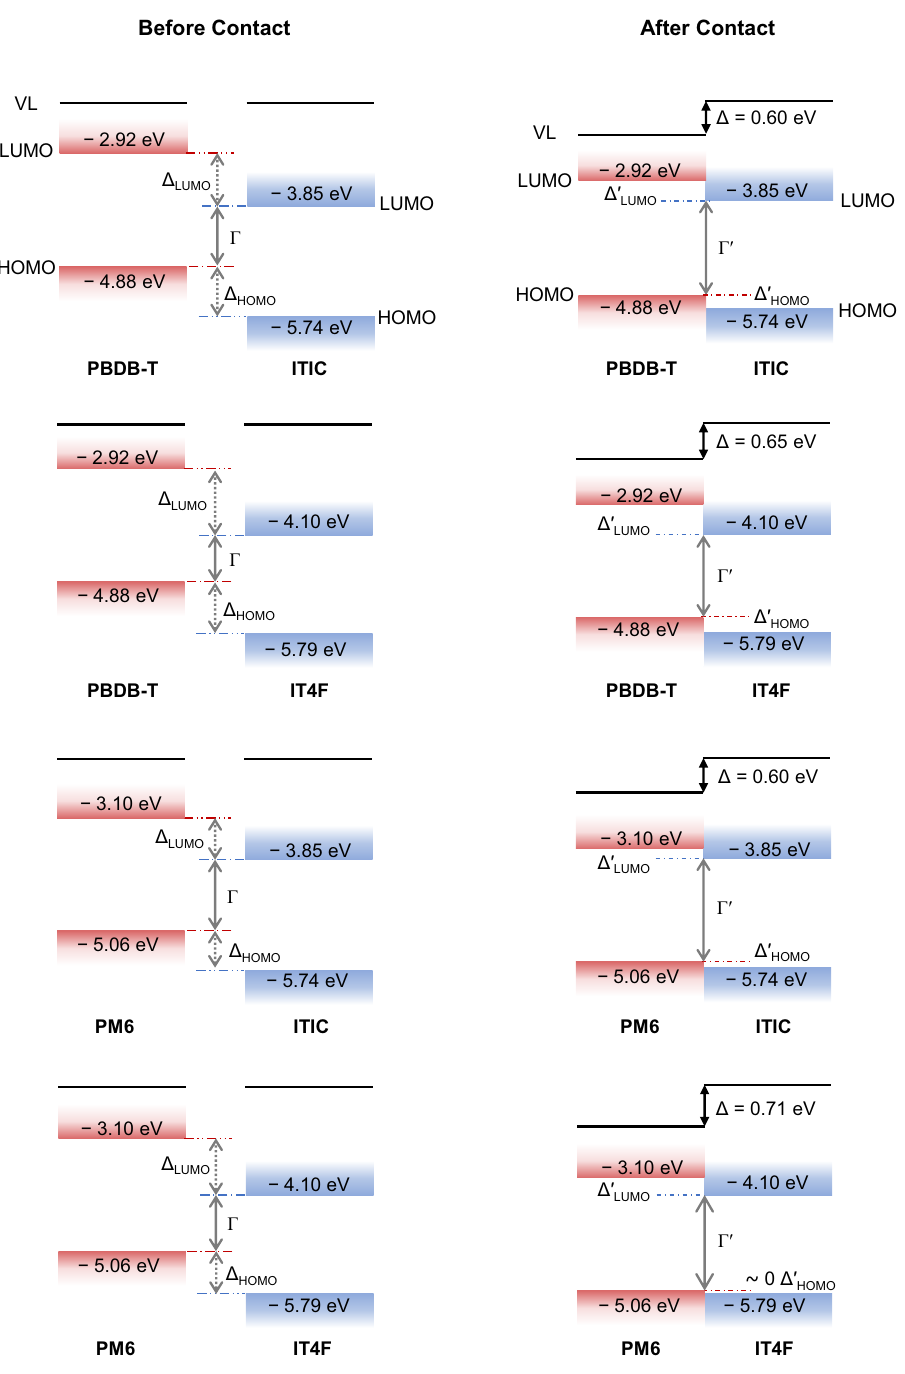
Fig. 3 Energy level diagrams of D – A interfaces before and after contact. All HOMO (highest occupied molecular orbitals) levels are measured by UPS, and LUMO (lowest unoccupied molecular orbitals) levels are obtained from literature and measured by inverse photoelectron spectroscopy (IPES) 21 , except for that of PBDB-T, which is obtained from the CV method 29 . HOMO difference between donor and acceptor before (after) conatct is denoted as Δ Δ ′ HOMO ( HOMO ). LUMO difference between donor and acceptor before (after) conatct is denoetd as interface before (after) contact is denoted as Γ ( Γ ′ ). Δ is the interface dipole inducing the vacuum level (VL)